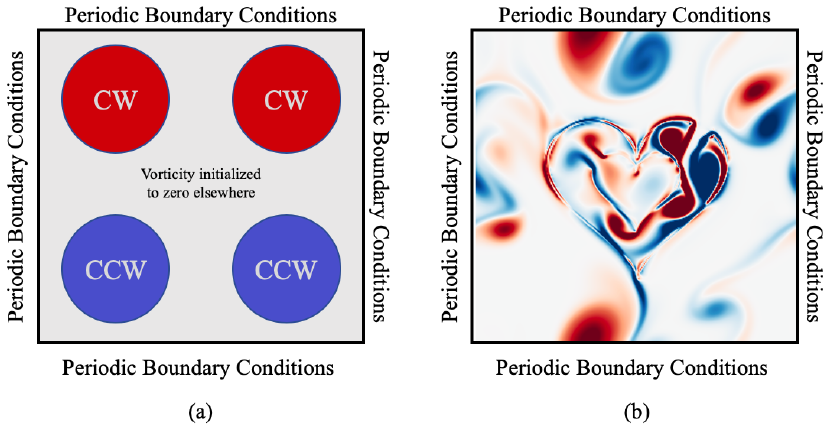
Figure 2. Illustrations of the boundary conditions and vorticity initialization for the cases of ( a ) interacting vorticity regions and ( b ) an initial vorticity field defined from a velocity vector